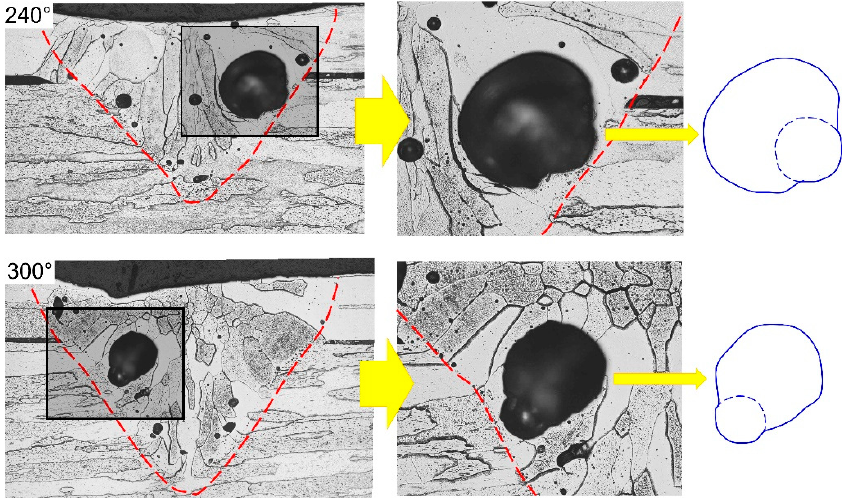
Figure 13. Large size pores with double curvature contour observed in Joint 2.